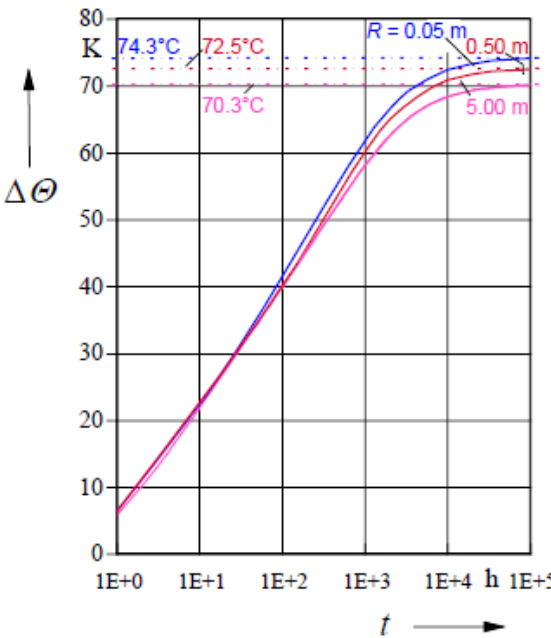
Figure 11. Transient temperature rise in the considered points of Figure 9 with maximum temperature rise for a loss step (p.u.l.) of W ′ = 100 W/m at t = 0; parameter: bending radius R.